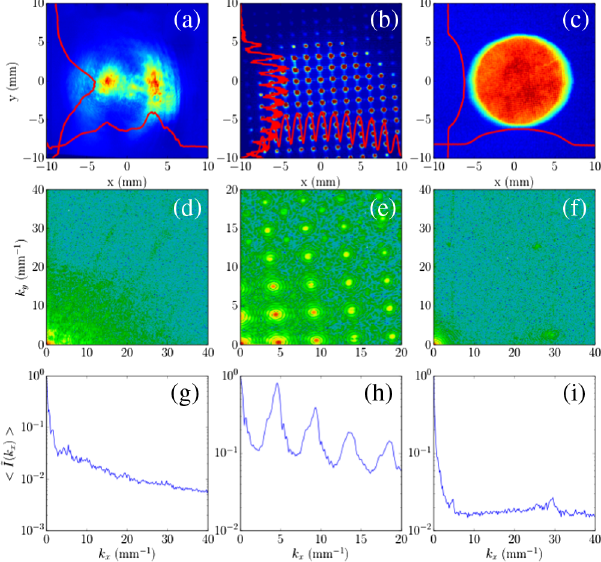
FIG. 3. Measured UV laser without MLA (left column) and with MLA setup to produce beamlets (middle column) or as a homogenizer (right column). The upper, middle and lower rows respectively correspond to the laser transverse density distribu- tion, its 2D FFT, and the projected spectrum along the horizontal spatial frequency k x .